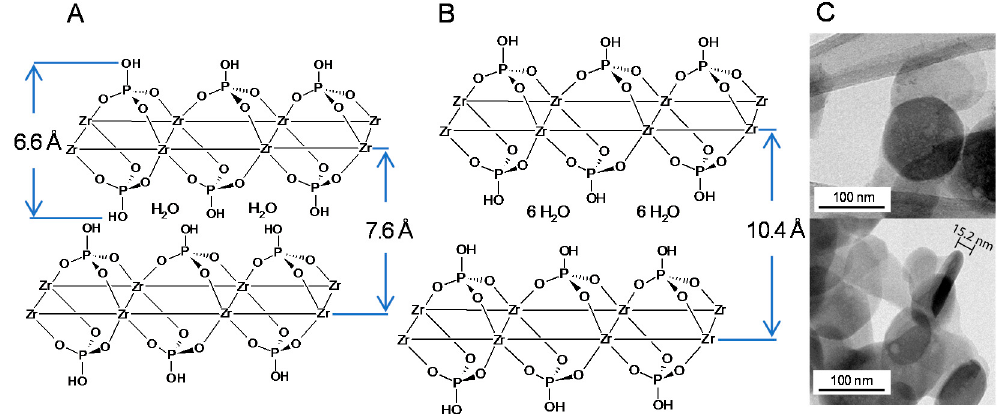
Figure 1. ( A ) The structure of α‐ ZrP; ( B ) the structure of θ‐ ZrP; and ( C ) TEM micrographs of α‐ ZrP nanoparticles where the top image shows the characteristic hexagonal shape and the bottom image shows the thickness of an α‐ ZrP nanoparticle.